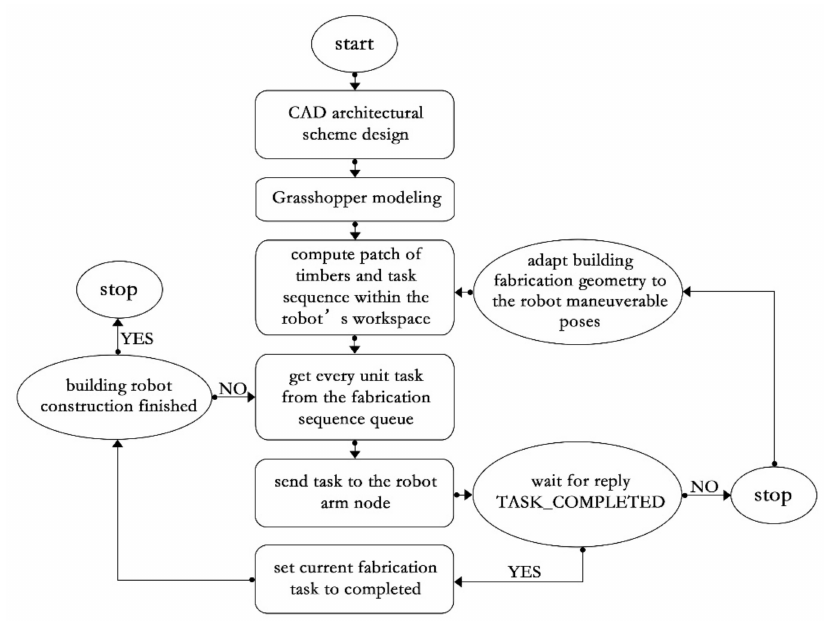
Figure 10. Flow chart for the construction control